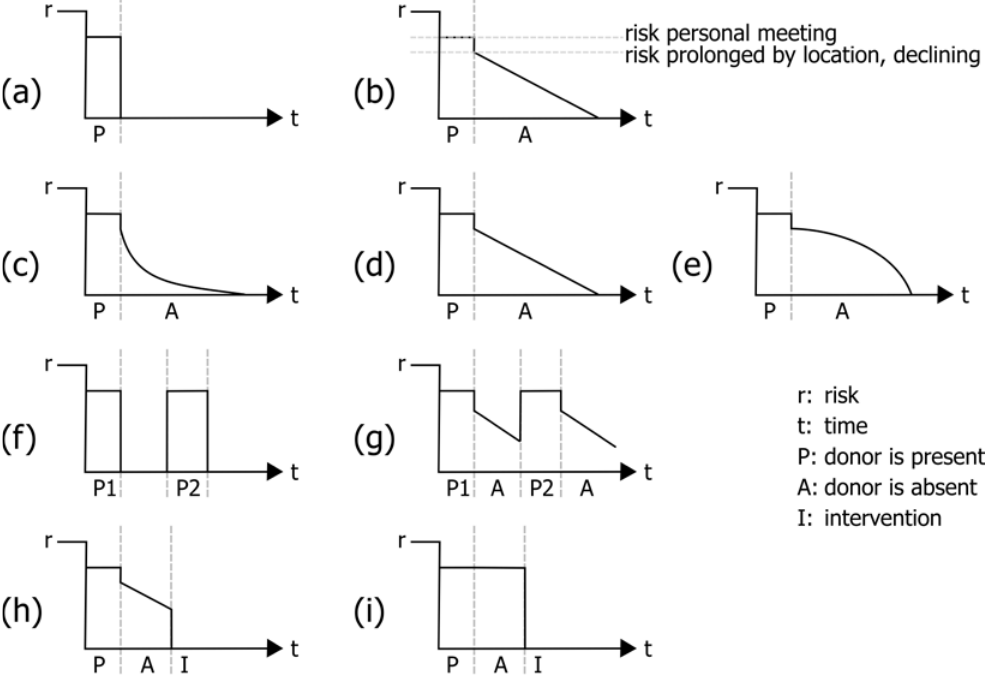
Figure 2. Timelines for infection risk at particular locations and settings. ( a ) infection risk with donor is present, ( b ) ongoing infection risk after donor left a location , ( c – e ) different kinds of decay of infection risk in time , ( f , g ) risk development of locations revisited by donor , ( h , i ) reset of infection risk after intervention at location .